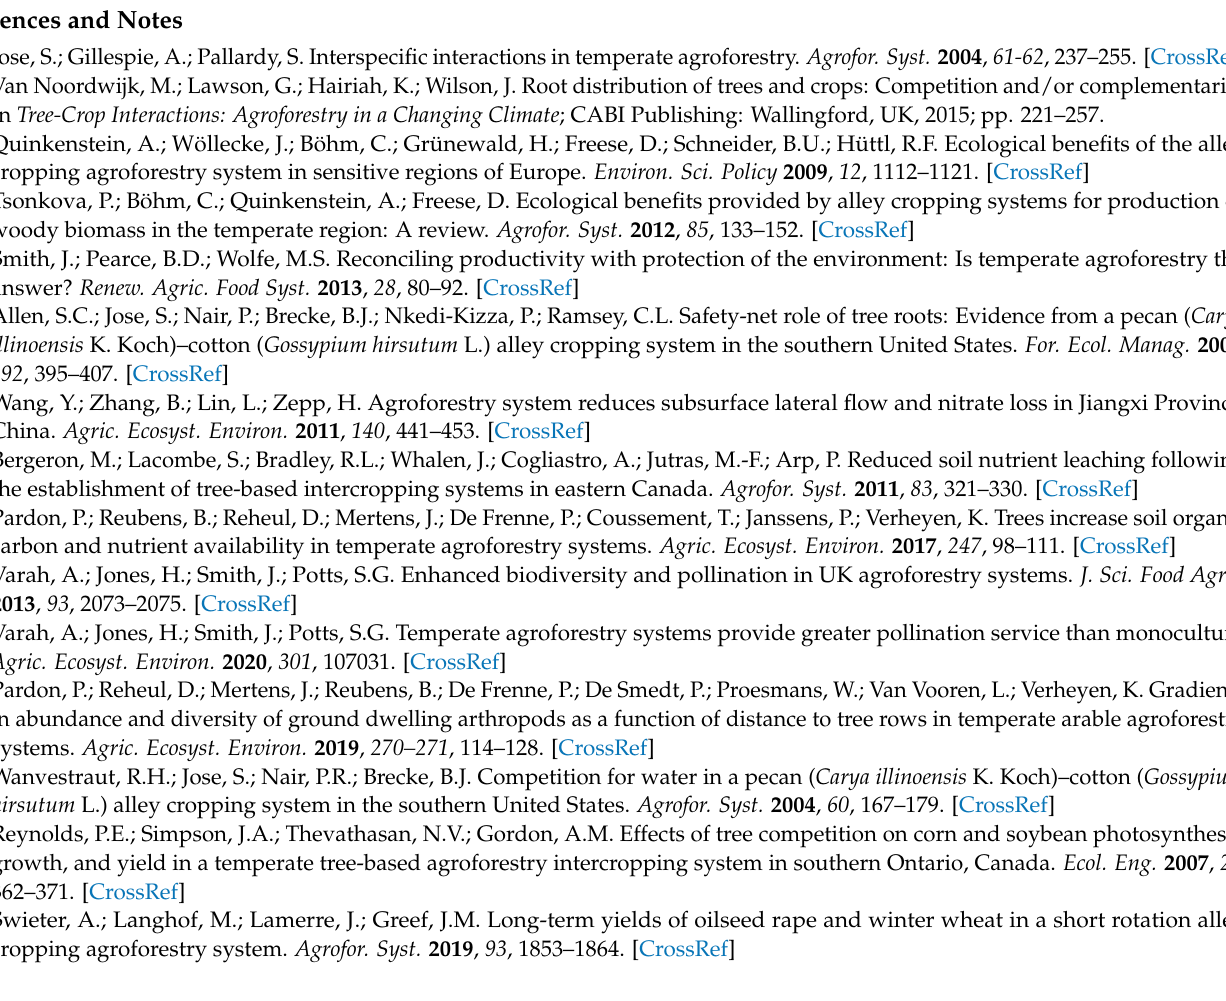
Table S2: Organisms that served as real-time PCR standards and primer sets used for the real- time PCR assays, Table S3: Mastermix composition used for the real-time PCR assays, Table S4: Thermocycling protocol used for the qPCR